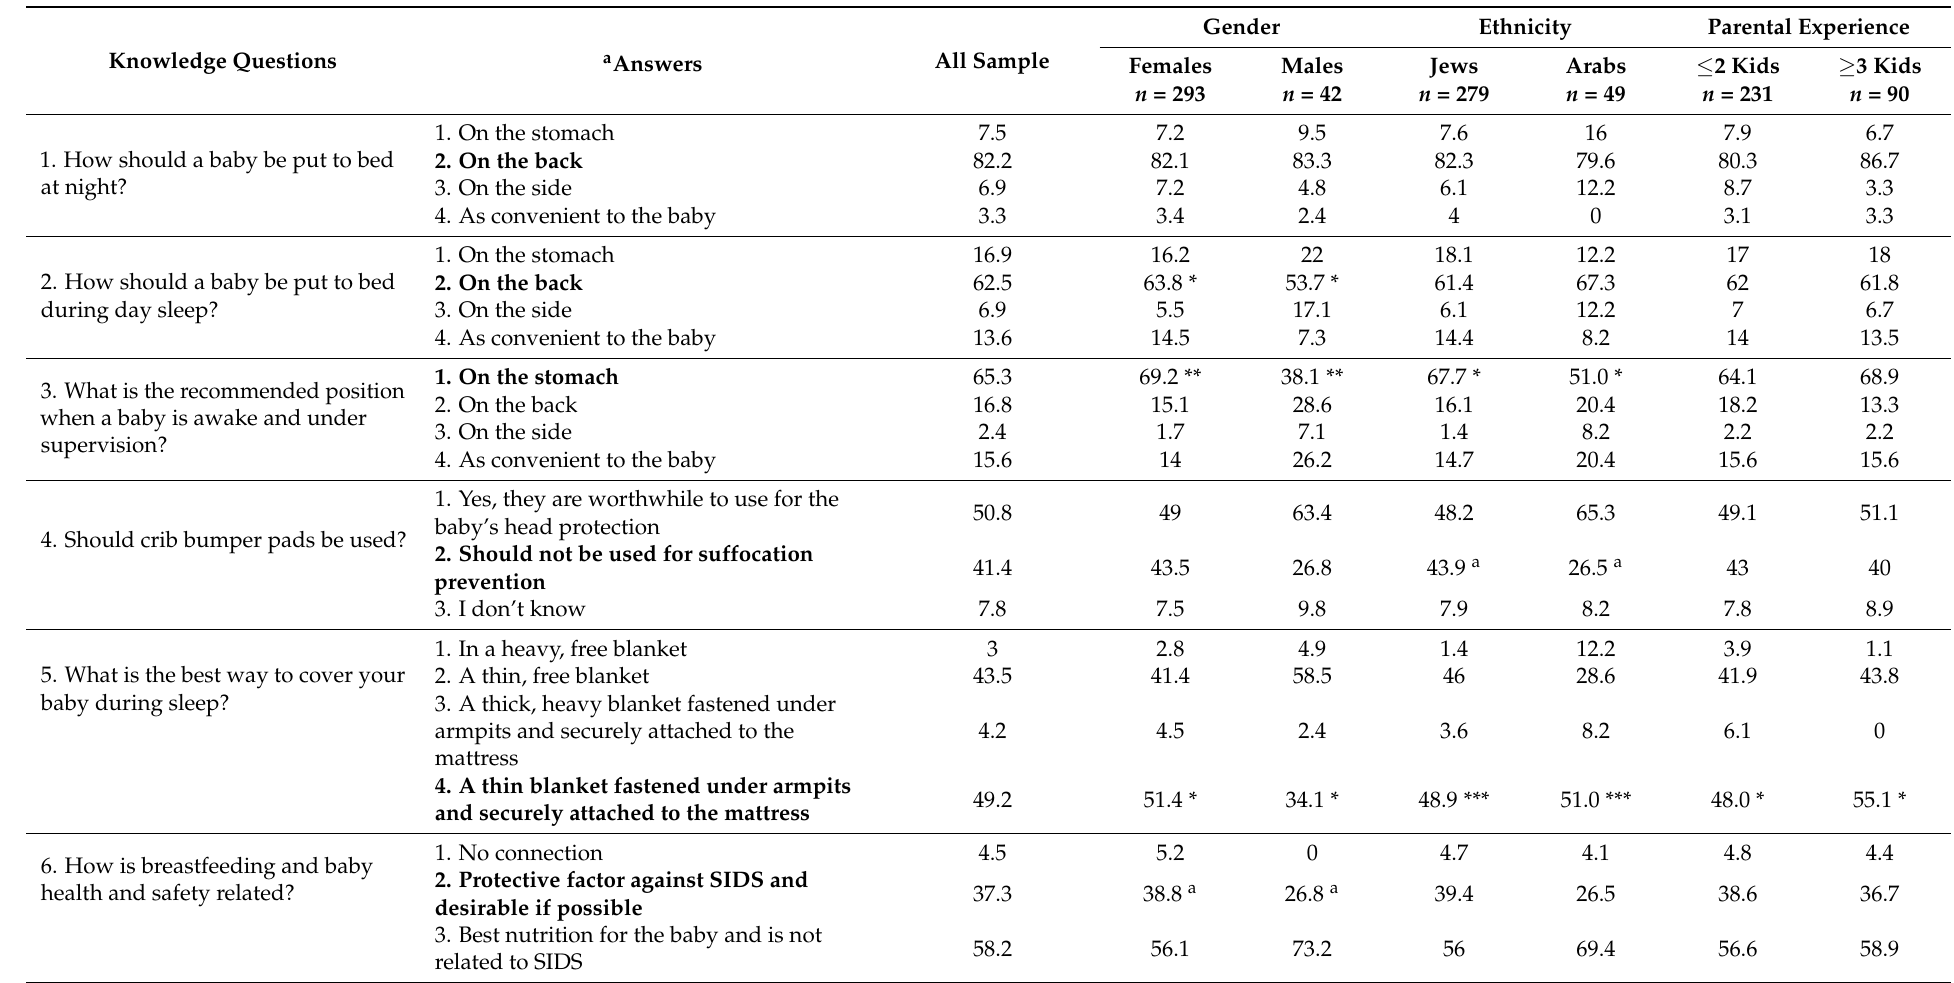
Table 2. Distribution of parental knowledge regarding safety sleeping for babies